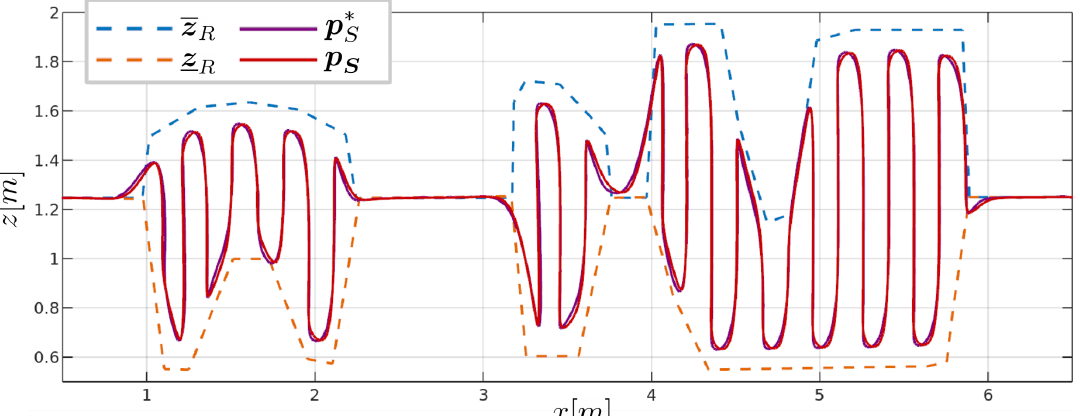
Figure 10. Overall spray frame reference tracking. p Ref generated based on the row description, where z R and z R represent the upper and lower foliage boundaries, respectively. The spray frame position p red line.